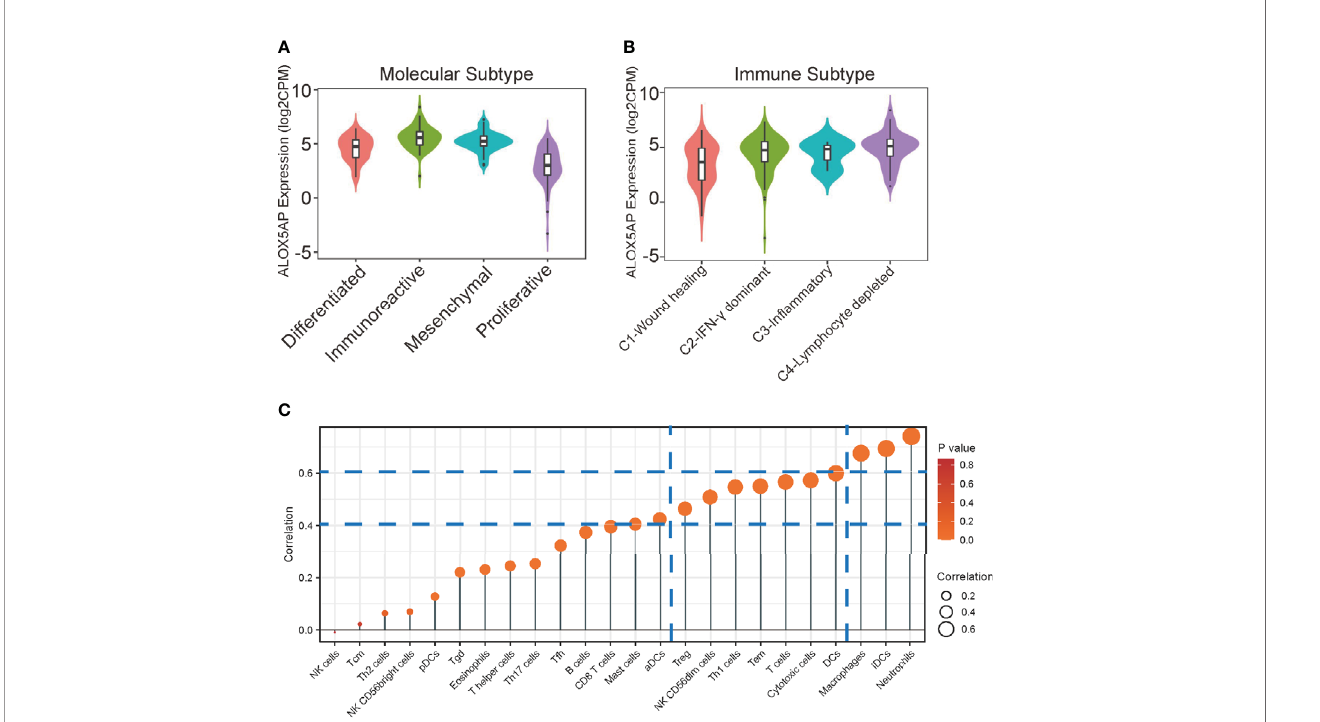
FIGURE 6 | Relationship between ALOX5AP and immune in fi ltration. (A) ALOX5AP expression levels in different molecular subtypes of SOC. (B) ALOX5AP expression levels in different immune subtypes of SOC. (C) Lollipop plot shows the correlation between ALOX5AP expression and 24 immune cell subsets in fi ltration in SOC microenvironment. The size of dots indicates the absolute Spearman r